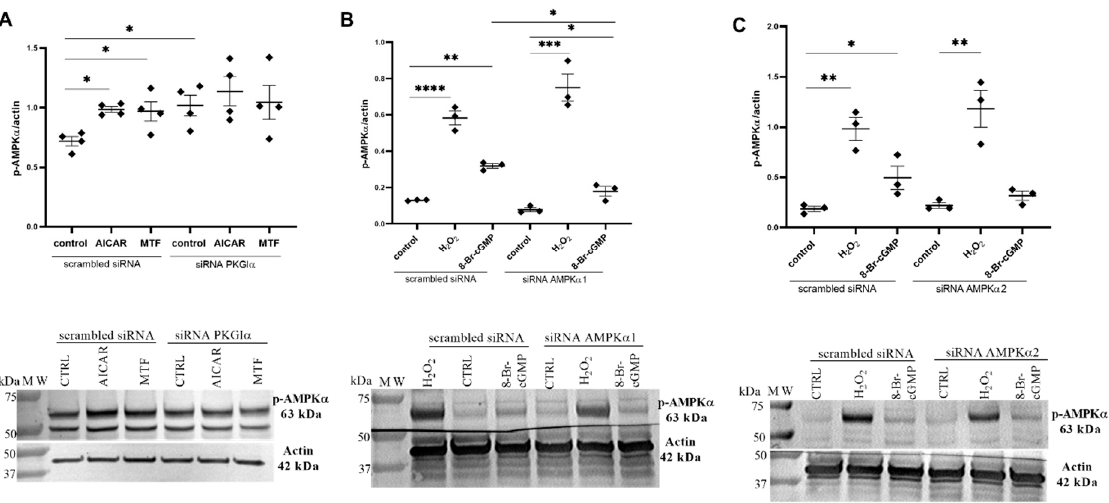
Figure 3. Interplay between PKGI α and AMPK affects AMPK activity. ( A ) Influence of PKGI α siRNA on AMPK phosphorylation in the presence of the AMPK activators MTF (2 mM, 2 h) and AICAR (100 μ M, 2 h); ( B , C ) Effect of AMPK α 1 ( B ) and AMPK α 2 ( C ) siRNAs on